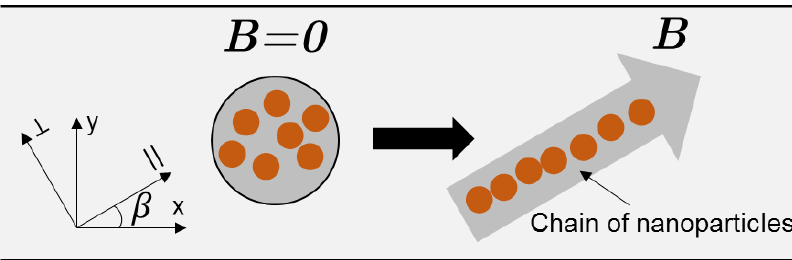
Figure 1. Schematic of the chain formation of nanoparticles. 𝑩 is the applied uniform magnetic field. || and ⊥ designate the parallel and the perpendicular directions of the magnetic field, respectively. z -coordinate is perpendicular to the x - y